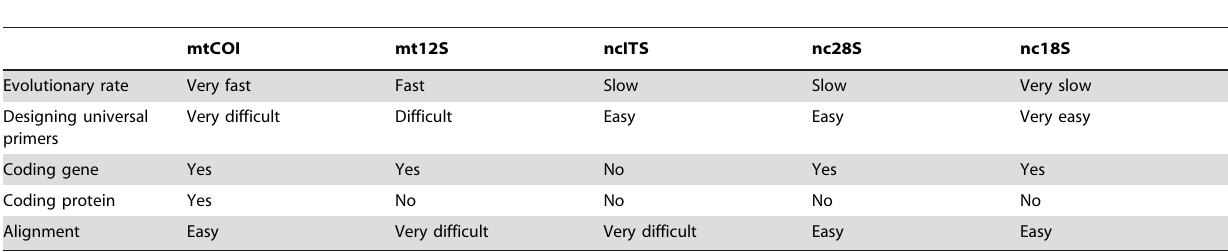
Table 4. Advantages and disadvantages of each gene region for metagenetic